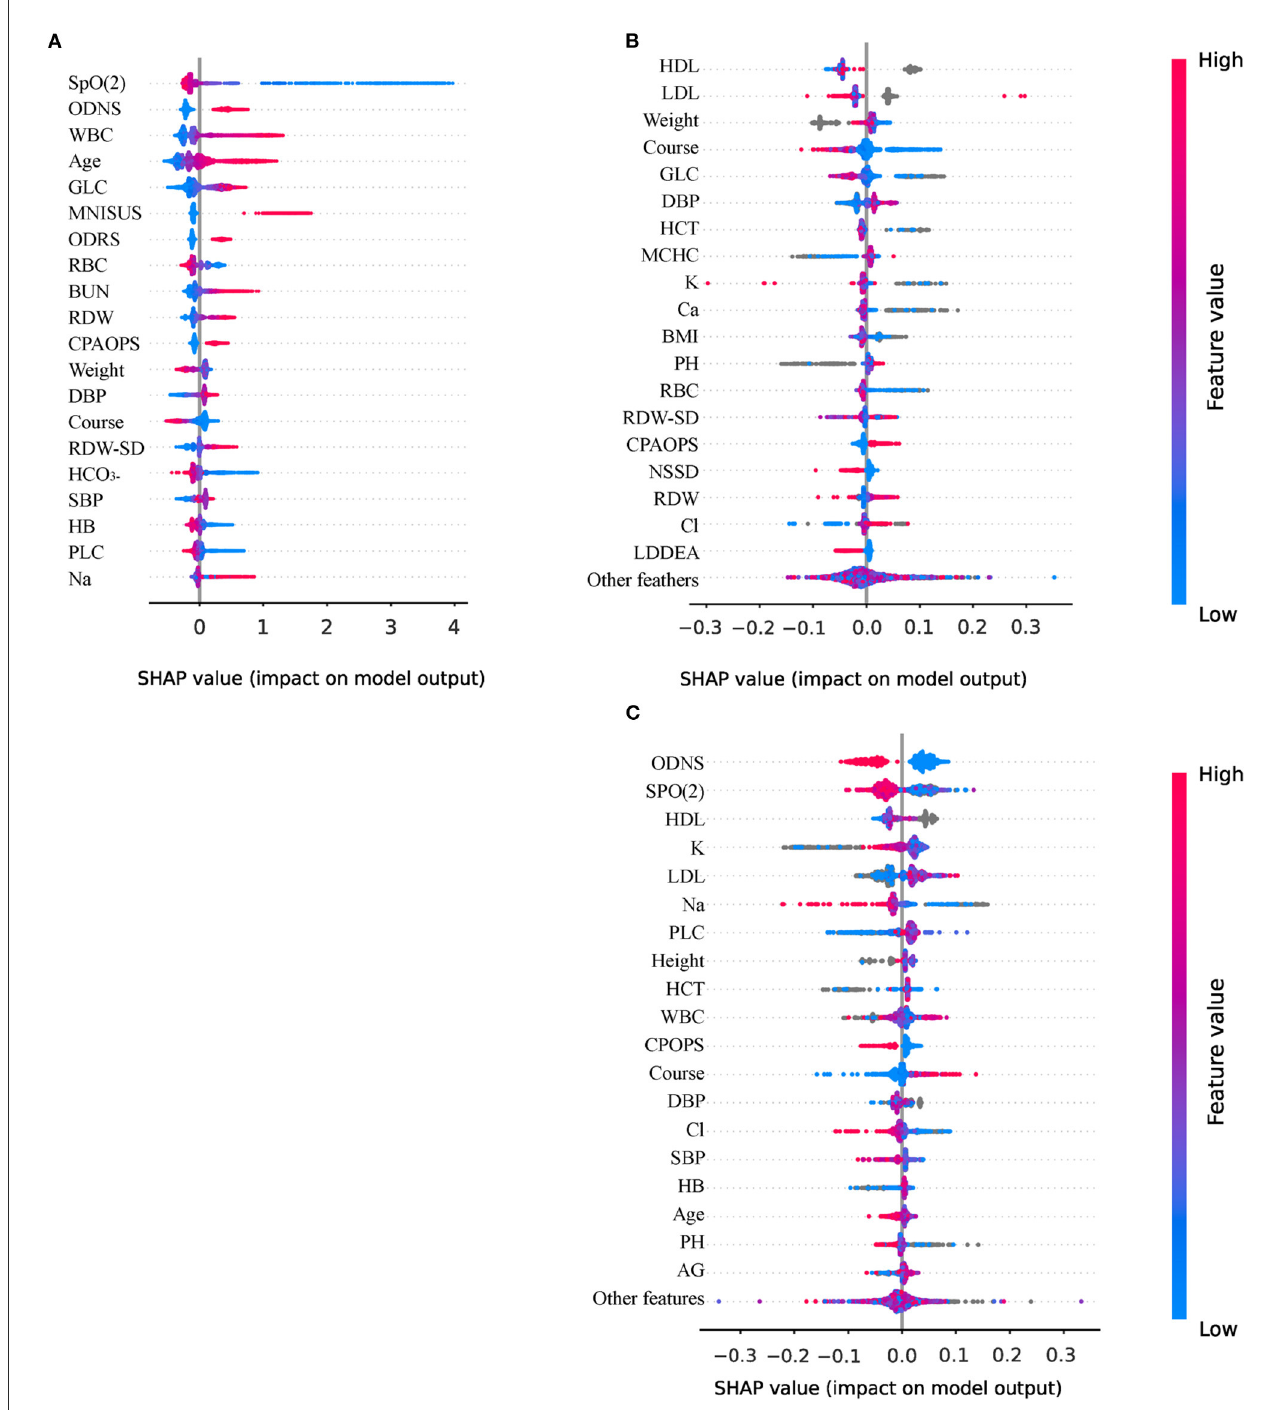
FIGURE4 Interpretation of models using Shapley Additive Explanations (SHAP) analysis. (A) The variables importance of CatBoost; (B) The importance of variables to explain warfarin treatment heterogeneity; (C) The importance of variables to explain human albumin treatment heterogeneity. ODNS, other disorders of the nervous system; WBC, white blood cell count; GLC, blood glucose; MNISUS, malignant neoplasms of ill-defined, secondary and unspecified sites; ODRS, other diseases of the respiratory system; RBC, red blood cell count; BUN, urea nitrogen; RDW, red blood cell distribution width; CPAOPS, cerebral palsy and other paralytic syndromes; DBP, diastolic blood pressure; RDW-SD, standard deviation of red blood cell distribution width; HCO 3 − , blood bicarbonate; SBP, Systolic pressure; HB, hemoglobin; PLC, platelet count; Na, blood natrium; HCT, hematocrit; MCHC, mean red blood cell hemoglobin concentration; Ca, serum calcium; K, blood potassium; NSSD, neurotic, stress-related and somatoform disorders; LDDEA, lung diseases due to external agents; Cl, blood chloride; HDL, high-density lipoprotein; LDL, low-density lipoprotein; AG, anion gap, PH; phosphoric